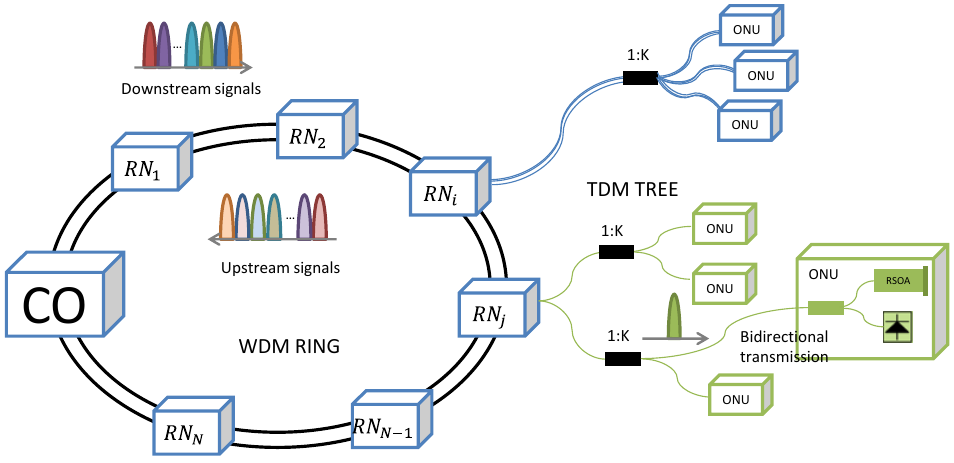
Figure 13. The SARDANA architecture [83].